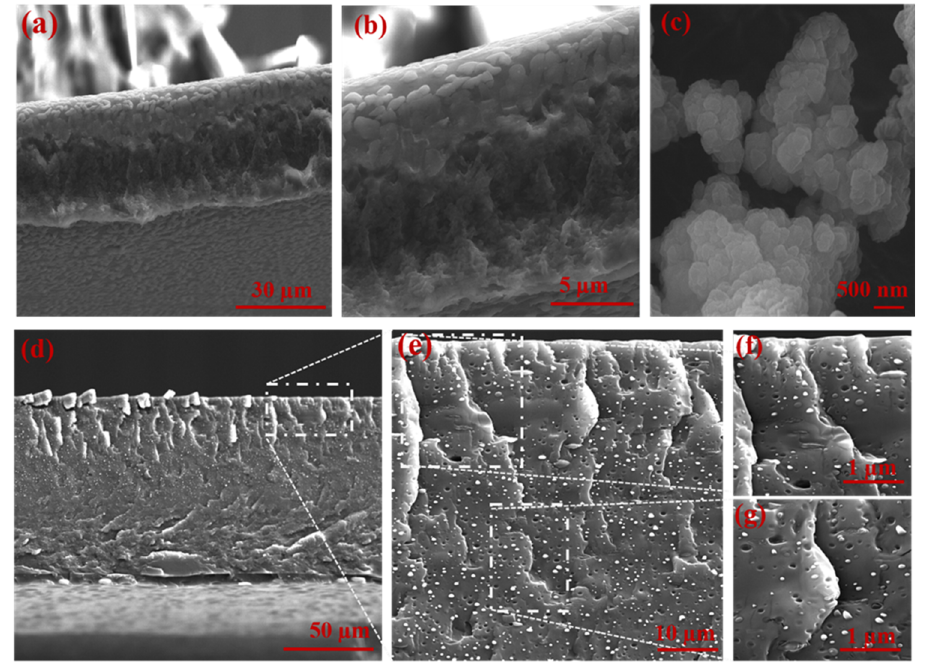
Figure 2. SEM images of cross-sectional view PVAm ( a , b ), UiO-66-NH 2 particles ( c ), and PVAm-UiO-66-NH 2 cross-sectional view ( d – g ).